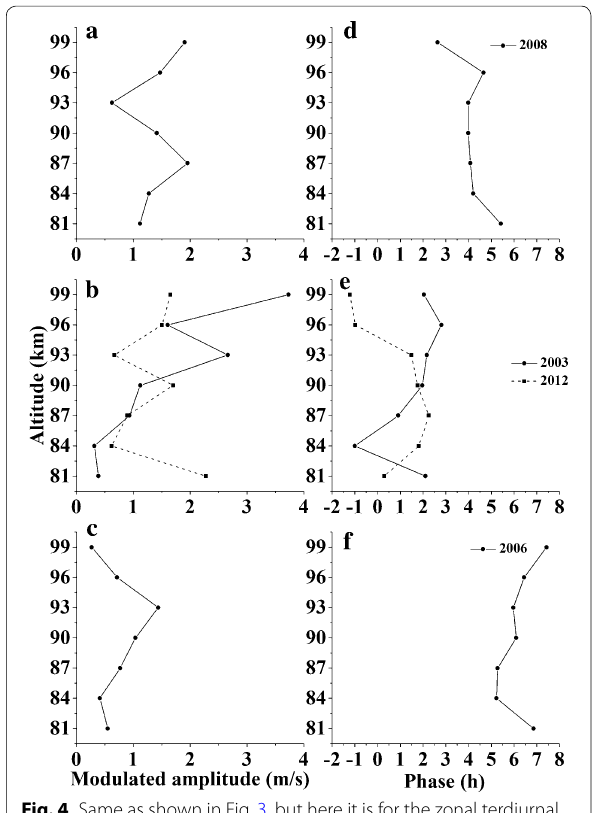
Fig. 4 Same as shown in Fig. 3, but here it is for the zonal terdiurnal tide